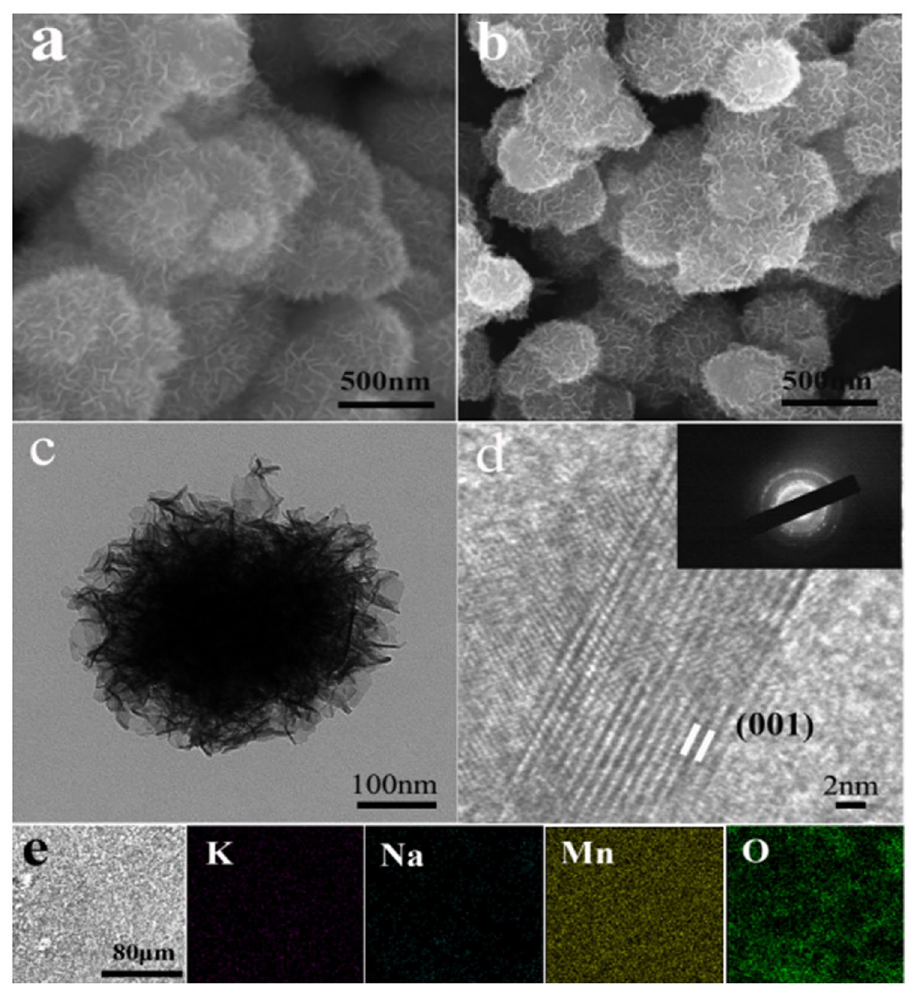
Figure 2. SEM images of ( a ) M0 and ( b ) M2, ( c ) TEM image of M2, ( d ) HR-TEM and SAED images of M2 and ( e ) EDS elemental mapping of